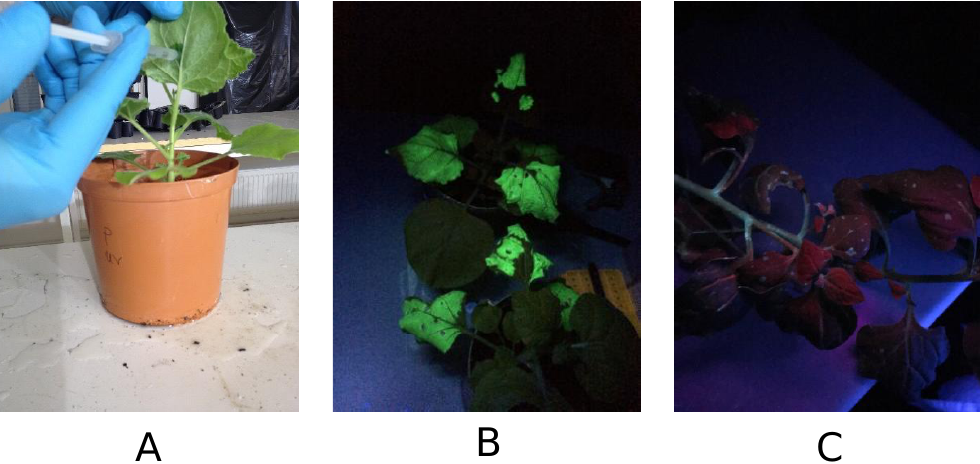
Figure 1. GFP expression in N. benthamiana and T. tetragonioides after agroinfiltration. ( A ) Syringe- infiltration of plant leaves with a mixture of A. tumefaciens cultures (OD 600 0.8 – 1.0) containing pEAQ-GFP and pJL3:p19 binary vectors. ( B ) N. benthamiana leaves showing strong GFP fluorescence. ( C ) T. tetragonioides leaves showing very weak GFP fluorescence.